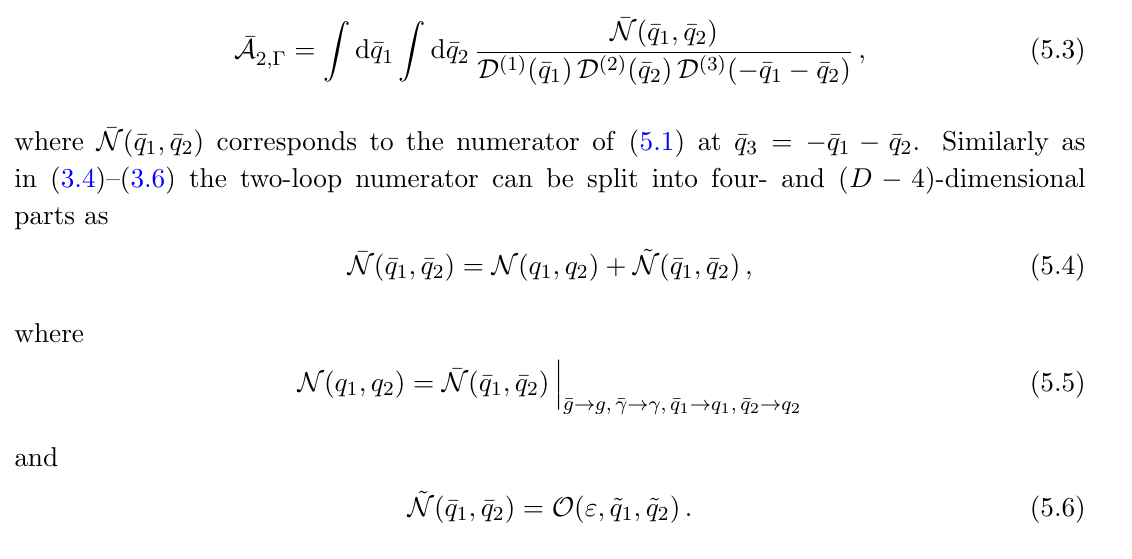
Figure 3 . A generic irreducible two-loop diagram consists of two vertices, chains, , , , which contain, respectively, all propagators that depend on the loop momenta C 1 C 2 C 3 q 1 , q 2 , q 3 = q 1 q 2 , as well as all vertices that connect the propagators depending on the same (cid:0) (cid:0) loop momentum. Note that in general the loop momenta that (cid:13)ow out of the q i + p i 0 , but for triple vertices one can set p i 0 = 0 as in the above graph. In contrast, if quartic vertex, momentum conservation requires non-vanishing p i 0 momenta with P the external momentum that (cid:13)ows into V 0